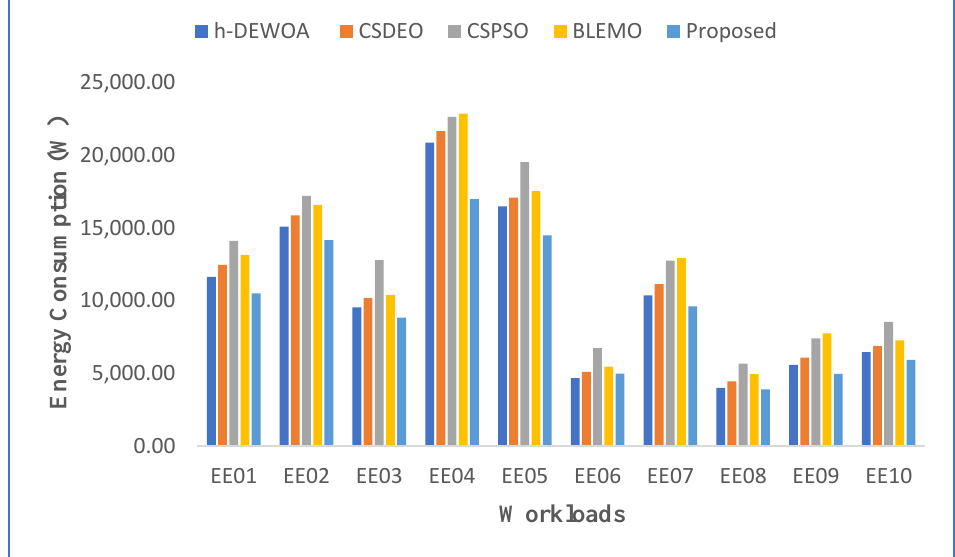
Figure 4. Comparison of energy consumption on CEA-Curie workloads.